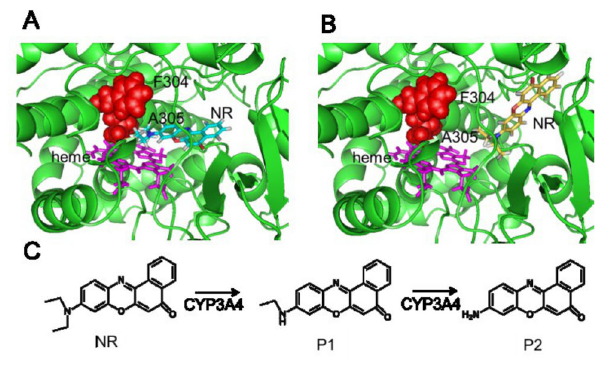
Figure 6. CYP3A4 interactions and metabolic fate of Nile red